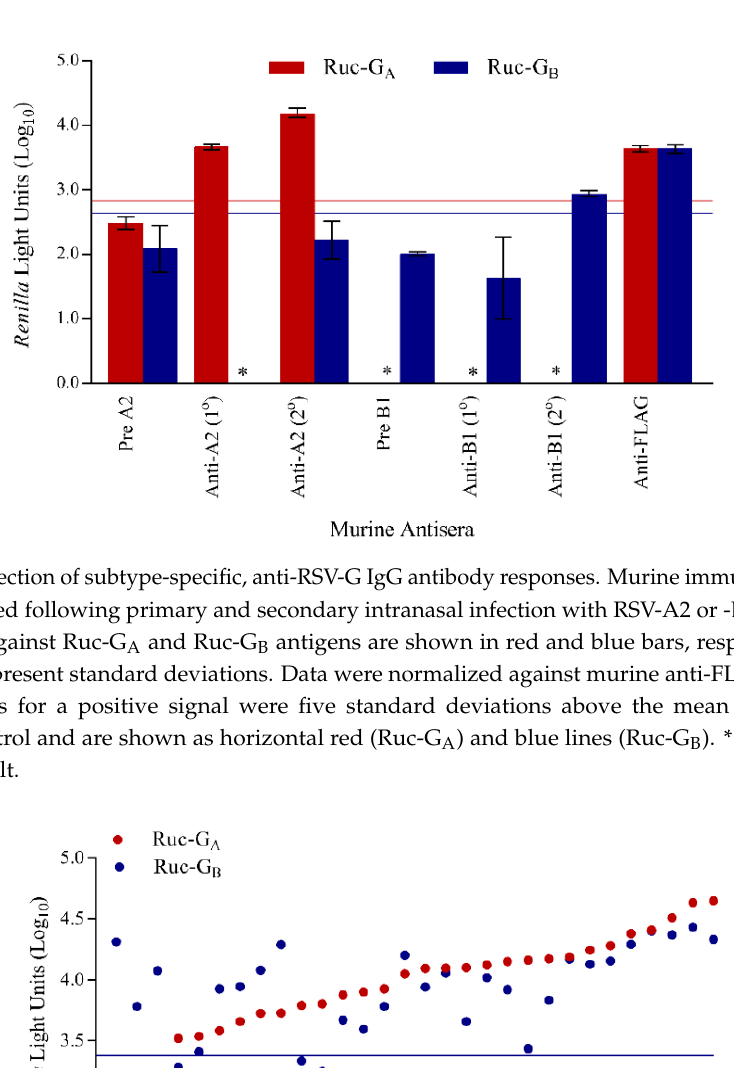
Figure 7. Detection of anti-RSV-G IgG antibody responses in human adolescent serum samples in LIPS-G A and LIPS-G B assays. Samples from 30 adolescent children, 10–14 years of age, were tested and data were normalized against reactivity of rabbit anti-FLAG antibody in each assay. Immunoglobulin depleted serum (Ig ∆ ) was used as the negative control and cutoff values are shown as horizontal red (Ruc-G A ) and blue lines (Ruc-G B ). Results are ranked from low to high based on testing against Ruc-G A (red circle) and paired with the corresponding result for each subject against Ruc-G B (blue circle) antigen.